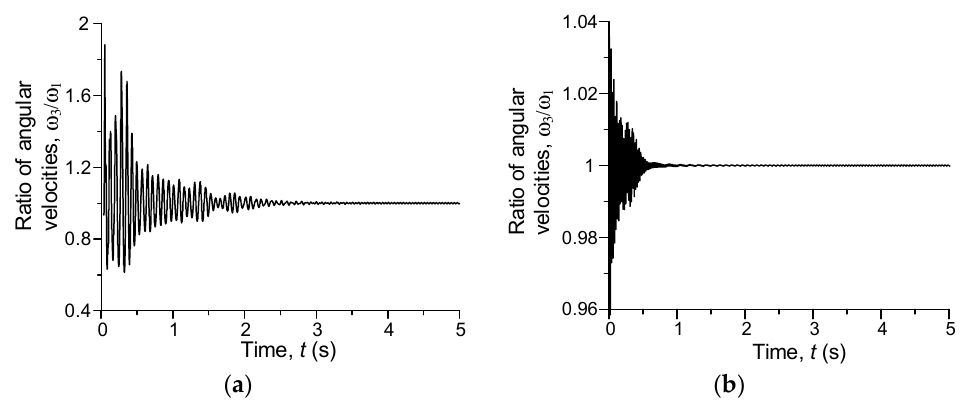
Figure 15. Ratios of the loading mechanism’s shaft rotational speed to the rotational speed of the rotor for: ( a ) D = 0.1 m α 1,2 = α 2,3 = π /5; ( b ) D = 0.3 m α 1,2 = α 2,3 = π /5. Figure 16 illustrate instantaneous stator A phase currents and the rotor’s virtual A phase currents.